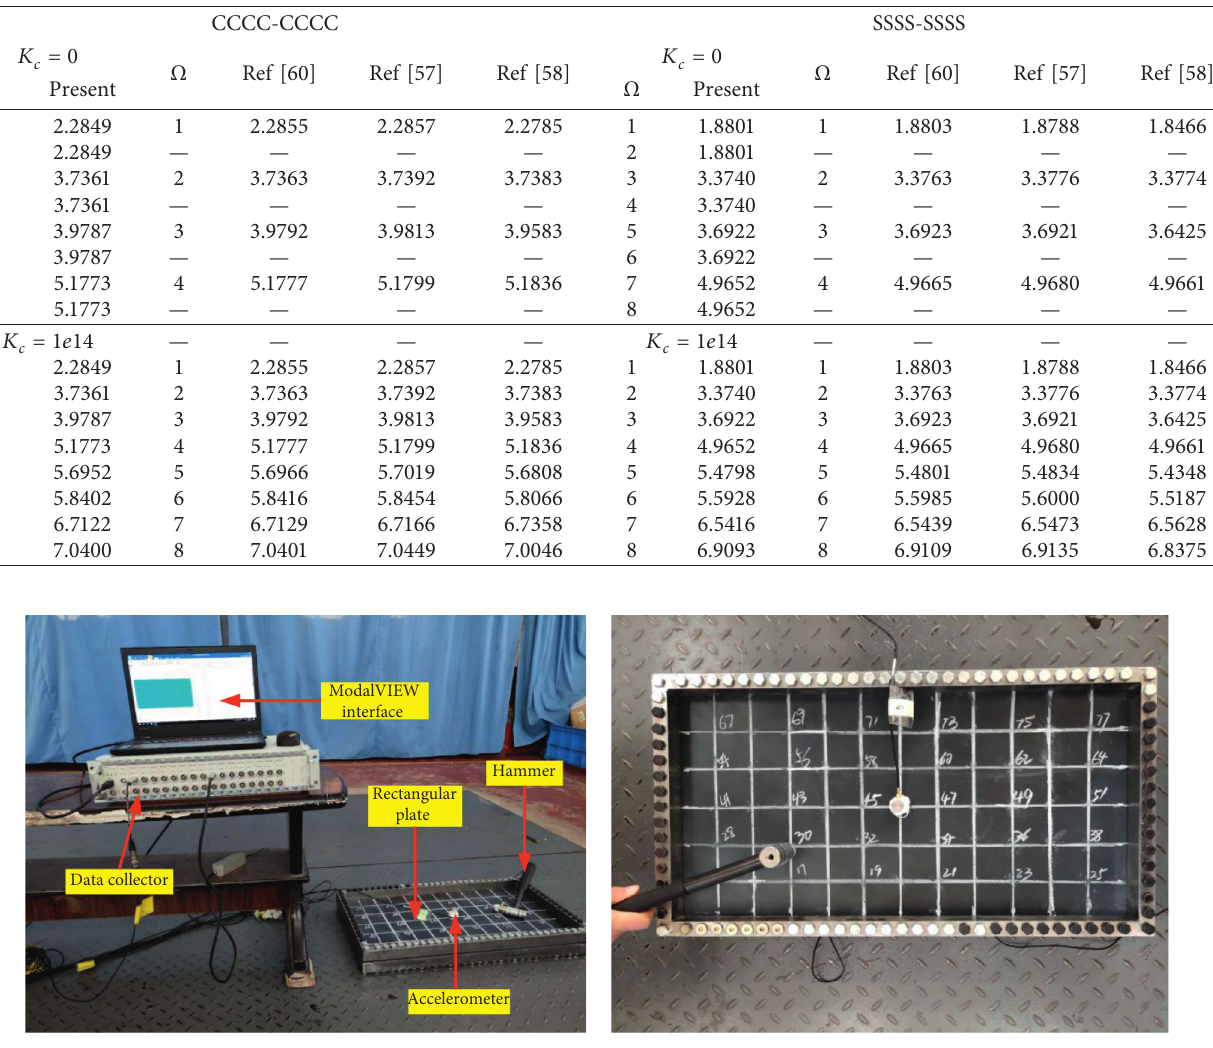
�������� 􏽰 h u 2 ρ u / E u . 2